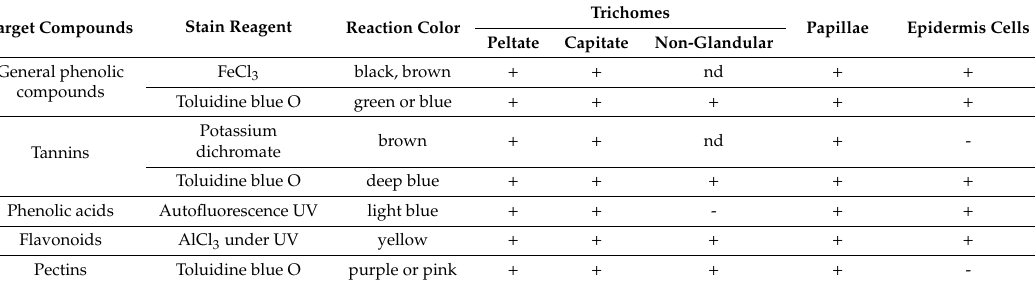
Table 1. Histochemical reactions of Lamium album subsp. album corolla trichomes. Target